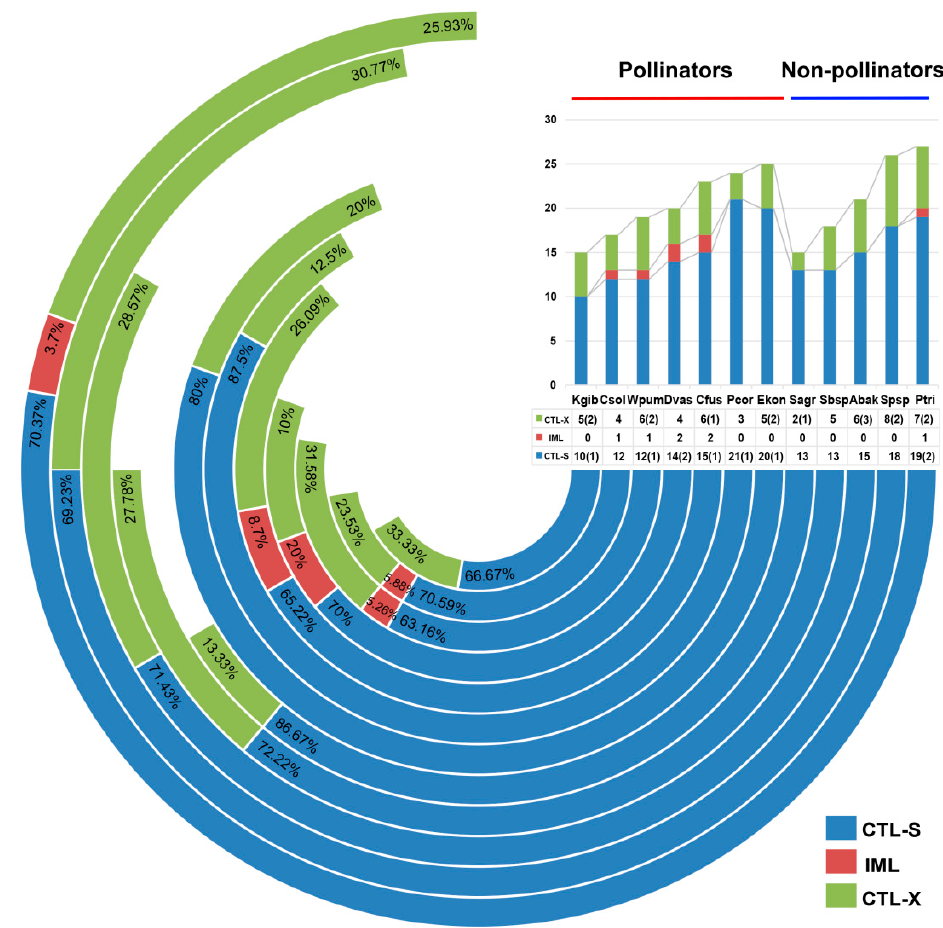
Figure 2. Statistical analysis of CTL types in the 12 fig wasp species. CTLs were divided into CTL ‐ S, IML and CTL ‐ X based on the domain characteristics. CTL ‐ S (blue) contained only one or three CTL domains, IML (red) contained two CTL domains, and CTL ‐ X (green) contained one or more CTL domains and additional domains. The column diagram on the top right showed the percentage of CTL ‐ S, IML and CTL ‐ X of 12 fig wasps, and the corresponding numbers were listed in the table below the diagram. The number in parentheses of CTL ‐ S represented the genes all containing three CTL domains, and that of CTL ‐ X represented the genes containing two or three CTL domains.